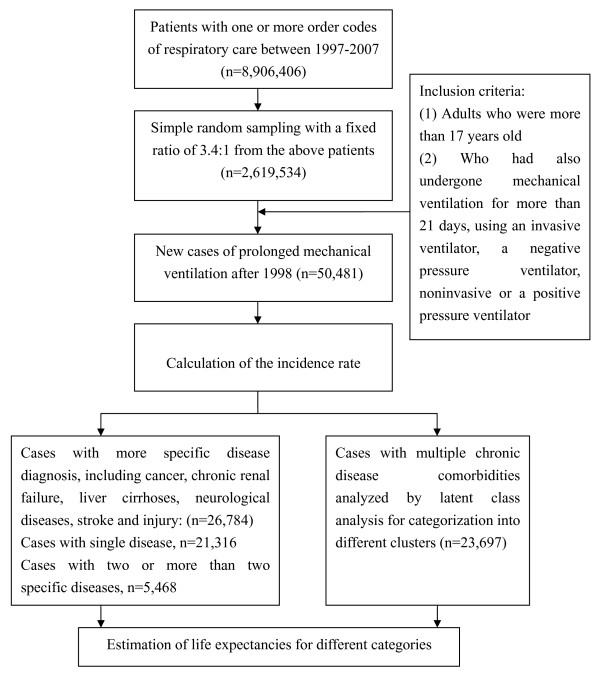
Flow chart of the selection process used for the study cohort.